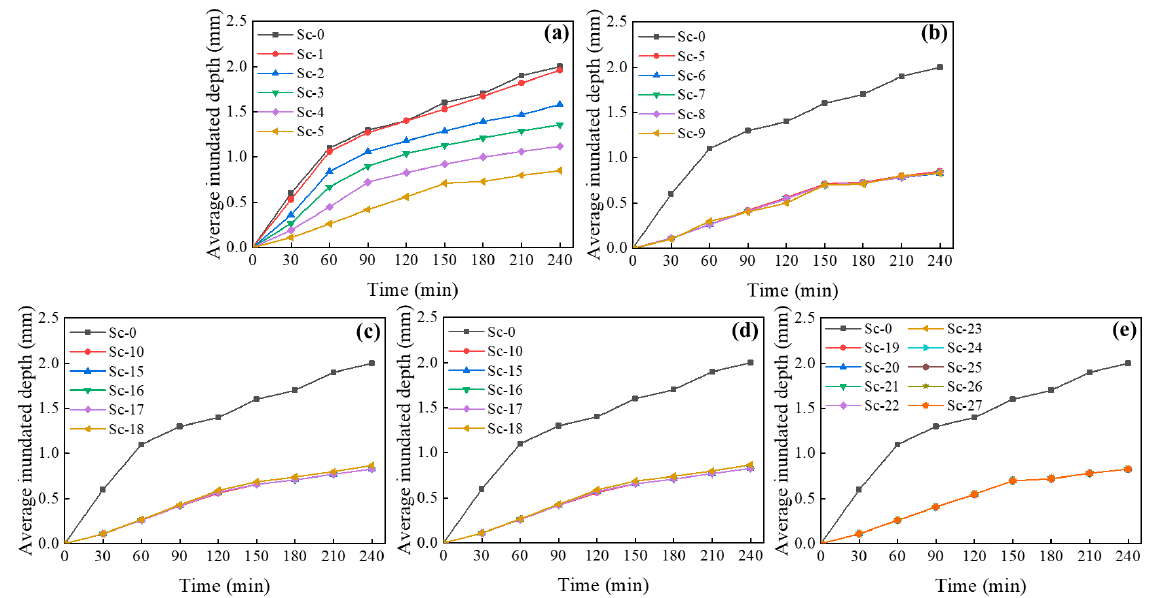
Figure 20. The time series plot of AID in 3 h event in considered scenarios of ( a ) connectedness of GR; ( b ) connectedness of RG; ( c ) edge density of GR; ( d ) edge density of RG; ( e ) flow distance of RG.